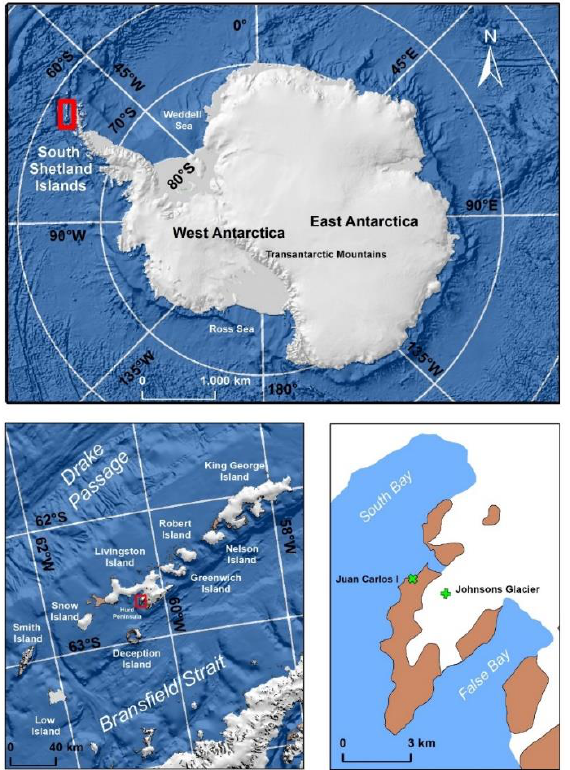
Figure 1. Location of the South Shetland Islands (red square, top image), and the study area on Livingston Island (red square, left hand bottom image). The locations of the Automatic Weather Stations are shown in the right bottom image.